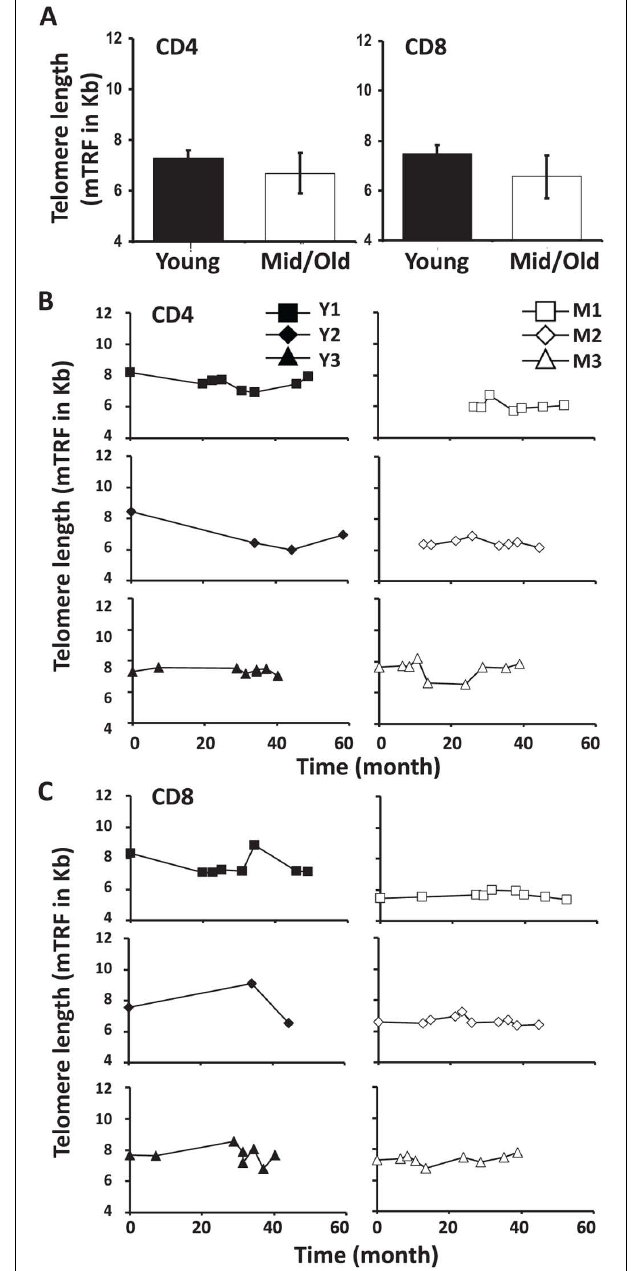
FIGURE 5 |Telomere attrition was higher in young than in middle-aged adults. (A) Telomere length of CD4 and CD8T cells from young and middle-aged donors are presented as mean and SD. (B) The CD4T cell Telomere lengths of each donor are shown, young (left), and middle-aged (right). (C) CD8Telomere lengths ofT cells from each donor are shown, young (left), and middle-aged (right).